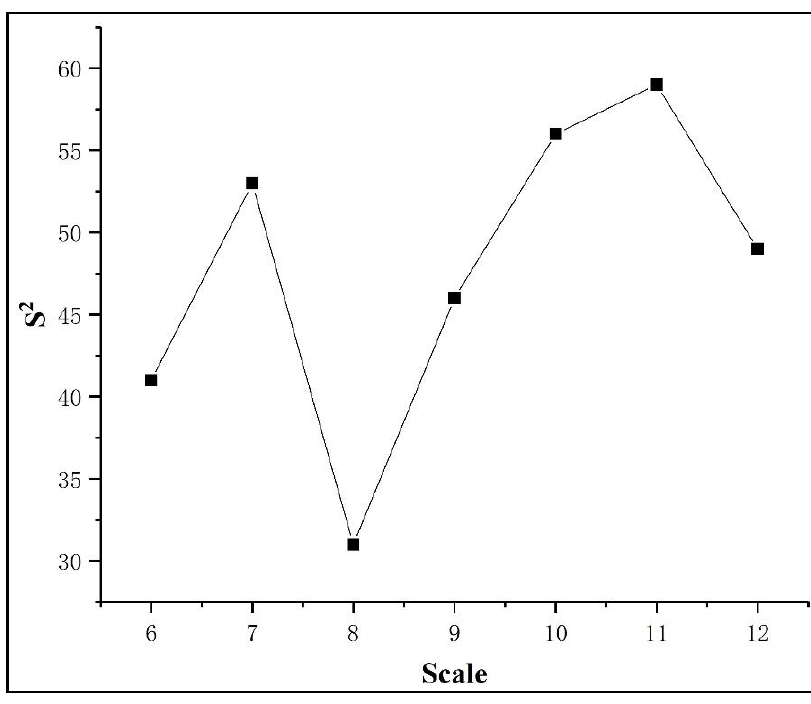
Figure 7. Results of weighted mean variances at different scales.